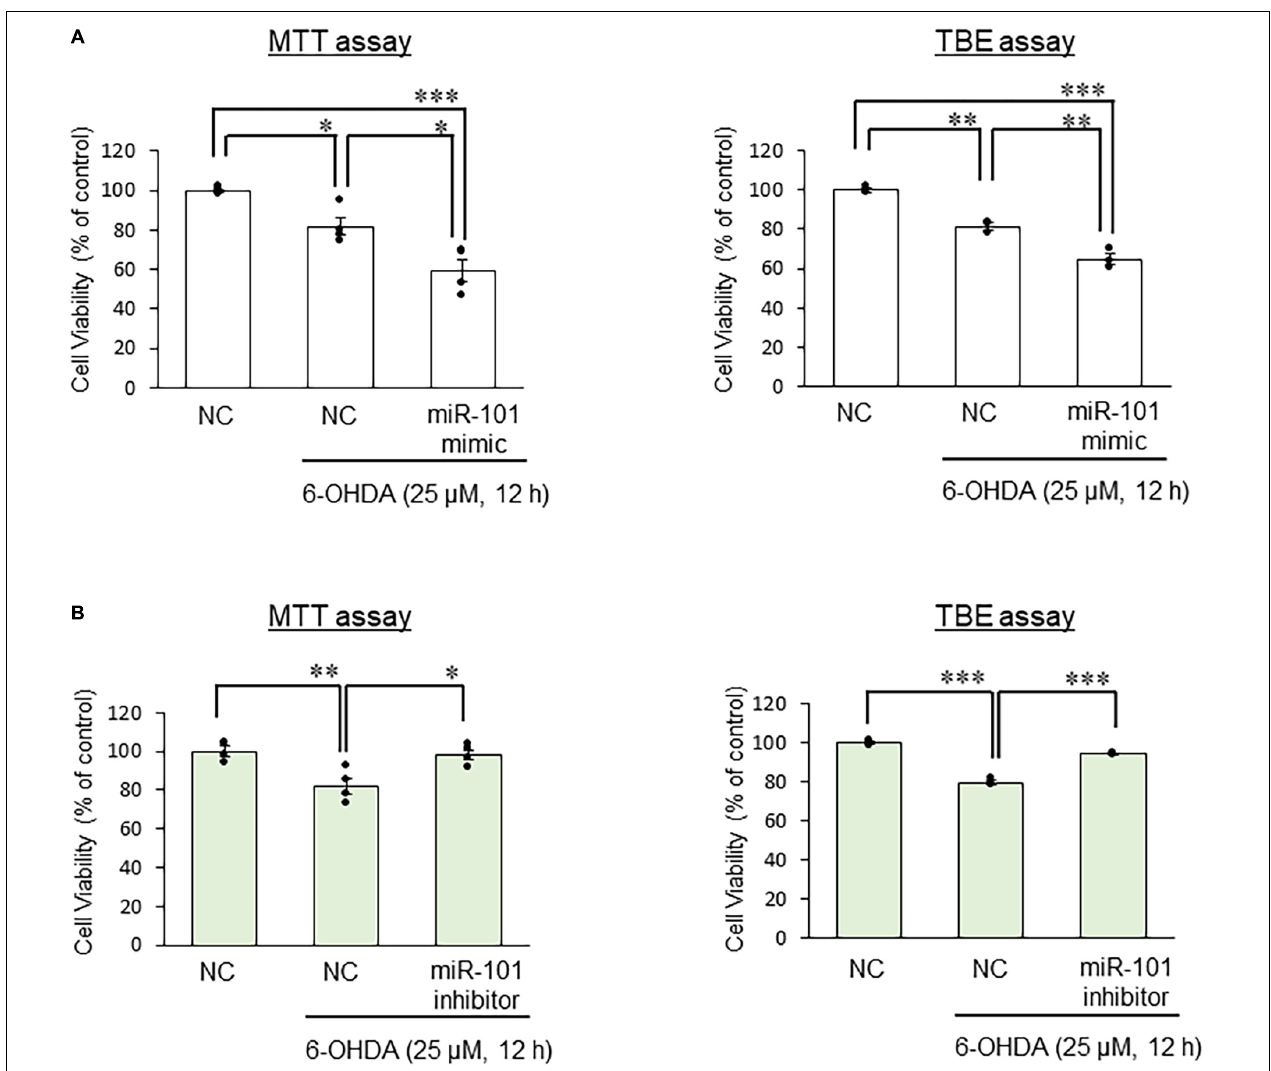
FIGURE 4 | Effects of miR-101 on 6-hydroxydopamine (6-OHDA)–induced cell death. (A,B) SH-SY5Y cells were transfected with the negative control (NC), miR-101 mimic, or miR-101 inhibitor for 48 h and then stimulated with 25 µ M 6-OHDA for 12 h. Changes in cell viability was expressed as means ± standard error of the mean of three (TBE assay) or four (MTT assay) independent experiments performed in duplicate. ∗ p < 0.05, ∗∗ p < 0.01, and ∗∗∗ p < 0.001, one-way analysis of variance with Tukey’s post hoc